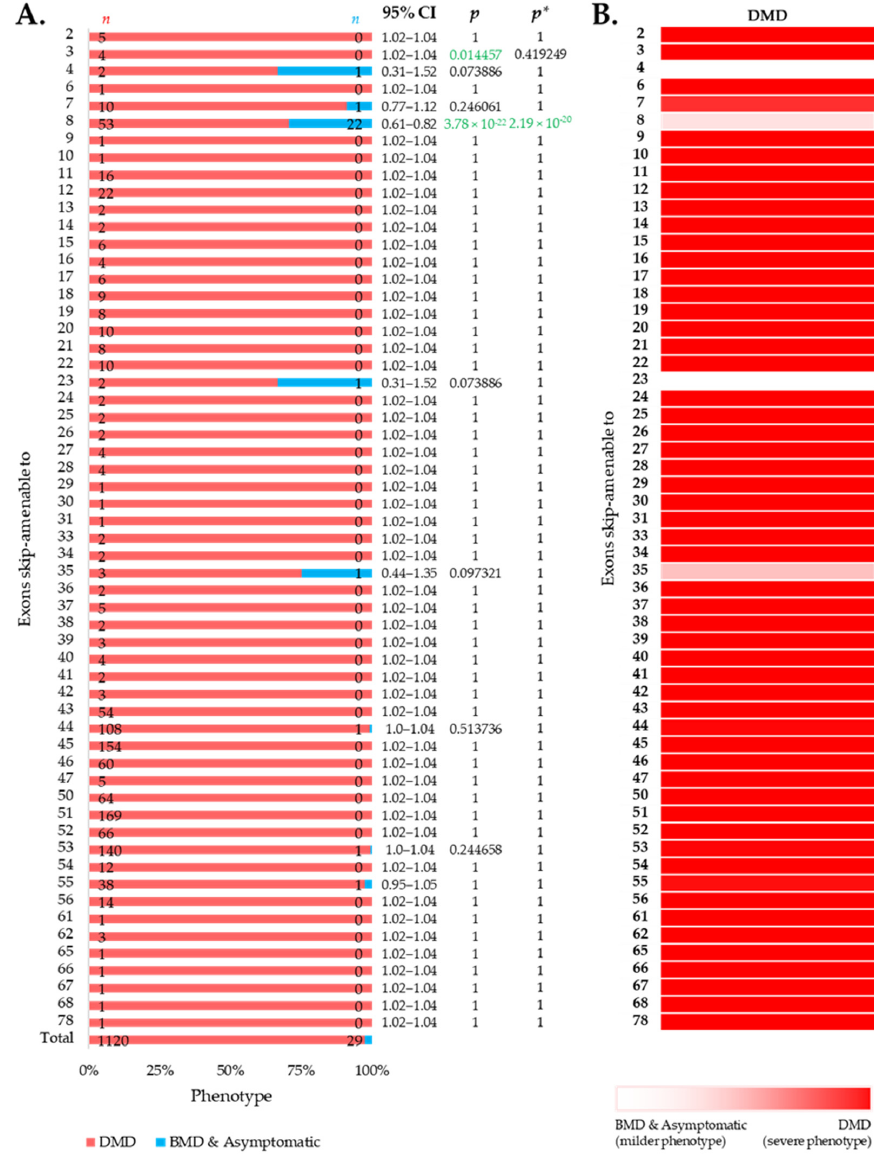
Figure 3. Phenotypic outcomes of exon skip-amenable mutations present in the UMD-DMD France database. ( A ) Distribution of phenotypes for each exon skip-amenable mutation. Phenotypic ratios associated with exon skip-amenable mutations for each exon vs. all other exons are compared using Fisher’s exact test. n indicates the number of individuals with DMD (red) and milder (blue; BMD and asymptomatic) phenotypes. Green color indicates a significantly lower incidence of DMD phenotype. p = p -value, as calculated by Fisher’s exact test; p * = Benjamini–Hochberg adjusted p -value. ( B ) Heatmap showing the relative severity of the consequence of out-of-frame mutations amenable to skipping of each exon.